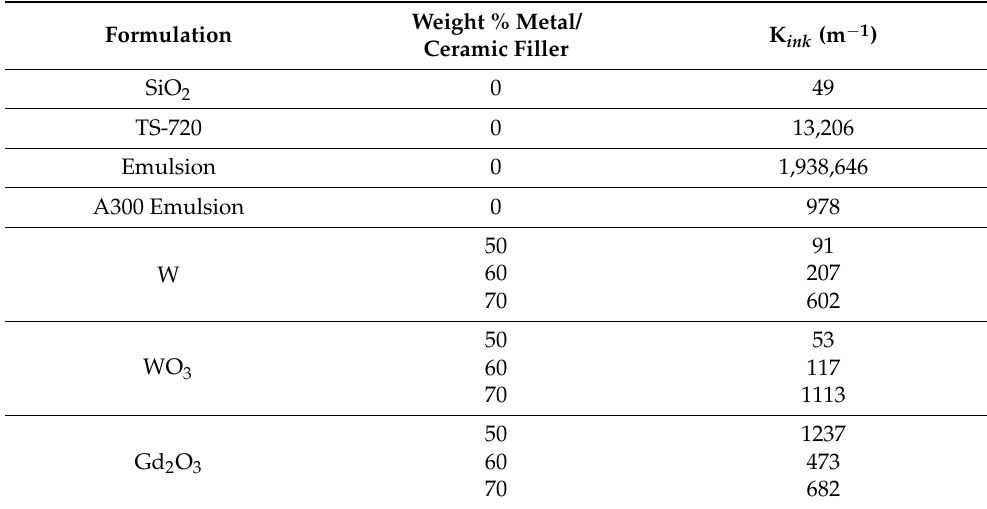
Table 4. Rheological properties of a representative sample of each ink formulation used in this study. Figure 5. Overall thickness deviation vs. spacing ratio ( η ) for 60 wt% Gd 2 O 3 prints using 250 µm and 410 µm nozzles with: ( a ) FCT geometries and ( b ) SC geometries.